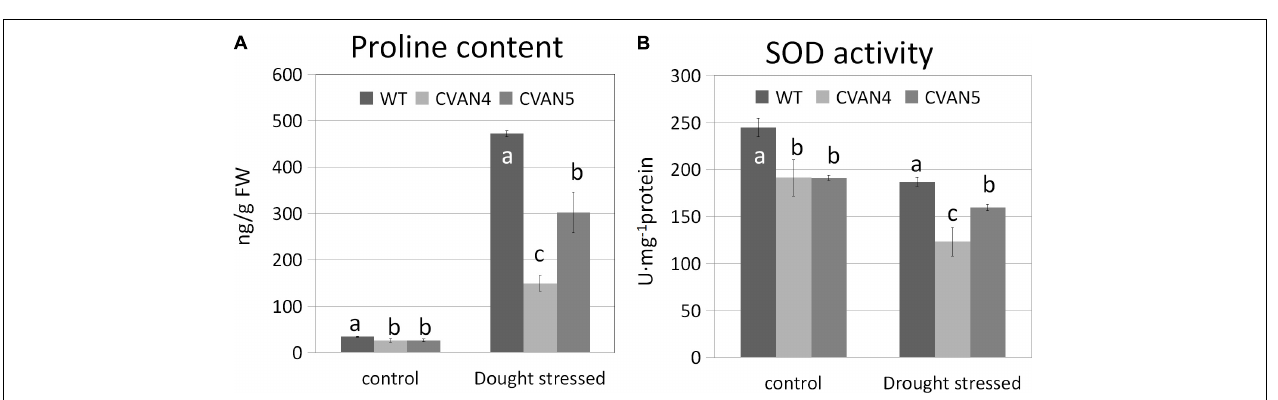
FIGURE 6 | Epidermal images of the WT and transgenic (CVAN4) plants under × 400 magnification (A) . Stomatal (B) and epidermal cell (C) density, stomatal aperture (D) , and stomatal size (E) of the WT and transgenic plants. Values represent the means ± SD ( n = 250–300). Photosynthesis rate (F) , transpiration rate (G) , and water use efficiency (H) under normal conditions and after dehydration for 26 days. Values are means ± SD for three independent experiments. Values with the same letter are not significantly different compared to the WT according to Duncan’s multiple range test ( P < 0.05). Bar = 30 µ m.